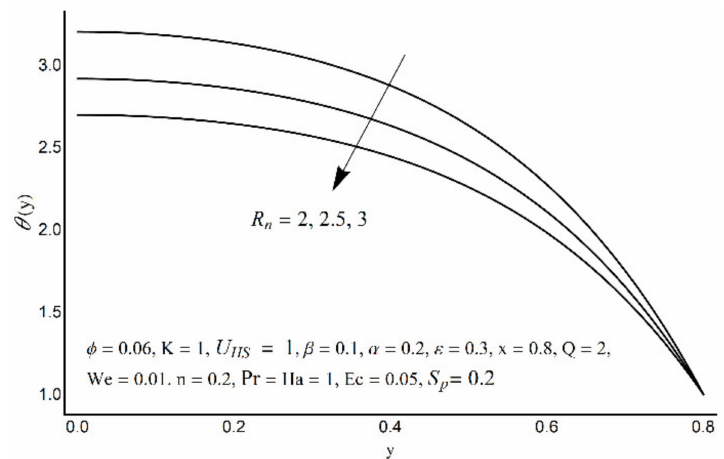
Figure 12. Temperature profile at various R n .